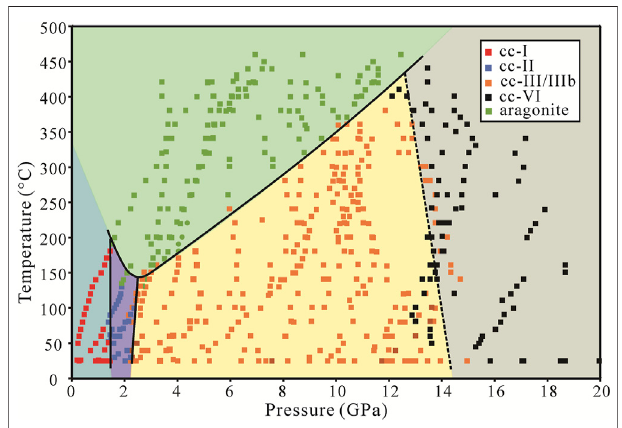
condition ( Figure 3 ), indicating